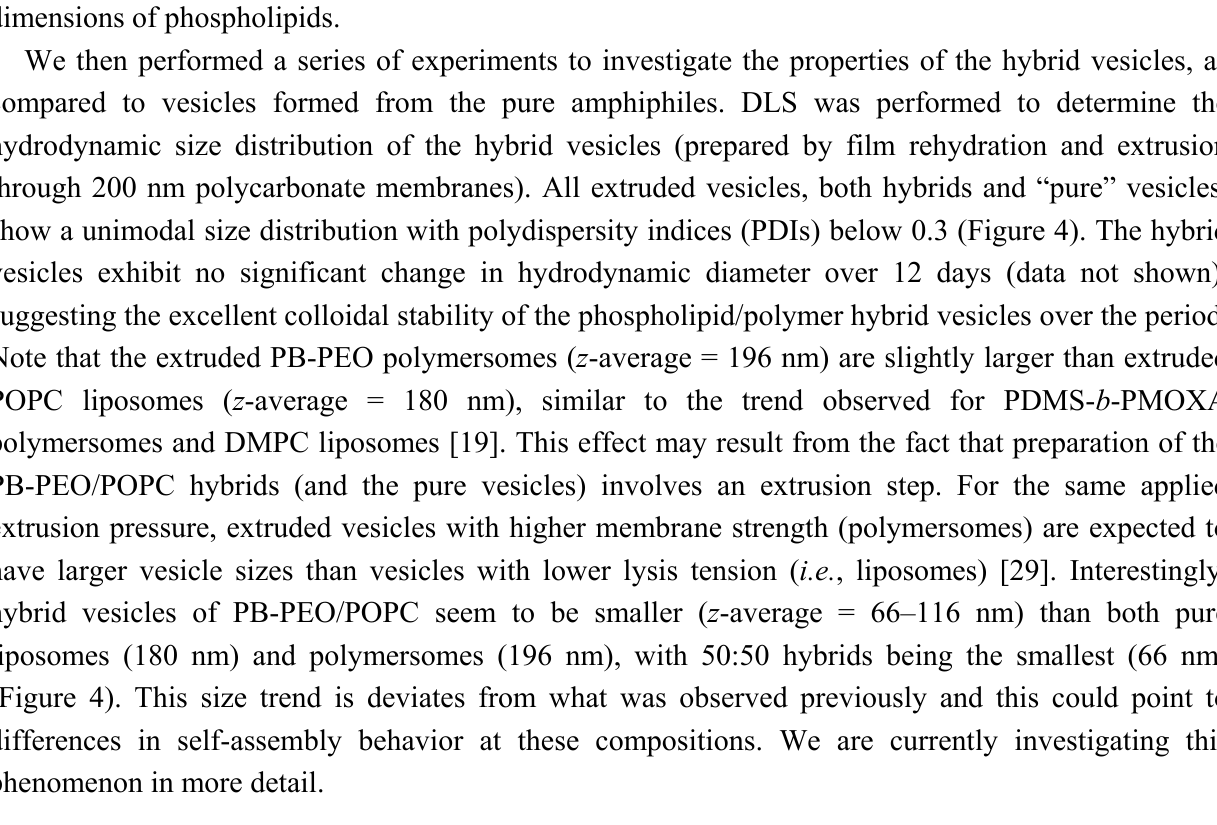
Figure 4. Intensity-weighted hydrodynamic diameter of extruded vesicles prepared from POPC, PB-PEO/POPC (75:25), PB-PEO/POPC (50:50), PB-PEO/POPC (25:75), and PB-PEO, as measured by DLS. All vesicles show a single unimodal